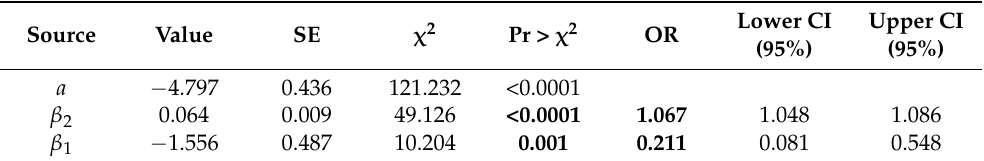
Table 11. The parameters of the logistic model characterizing the relationship between the variable Y 3 : “Have you been hospitalized?” and the variables X 1 and Z 1 (Model 5). Bold values indicate a statistically significant impact.